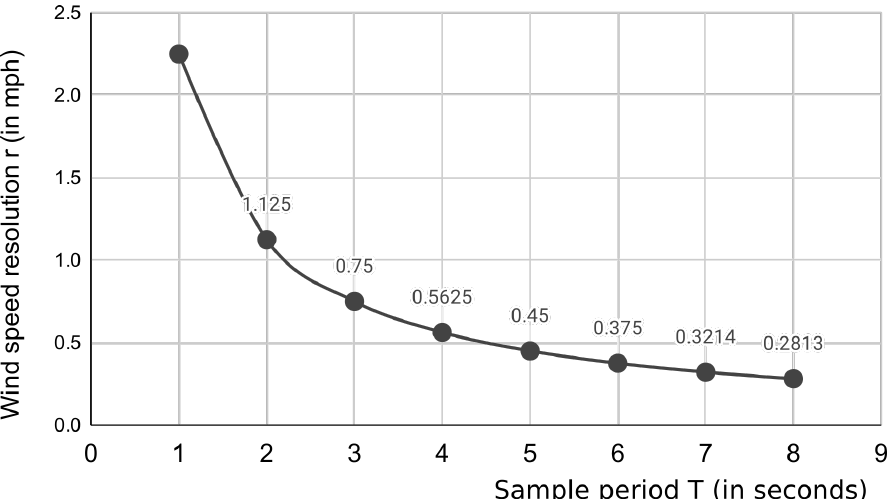
Figure 2. Sample period (T) vs wind speed resolution